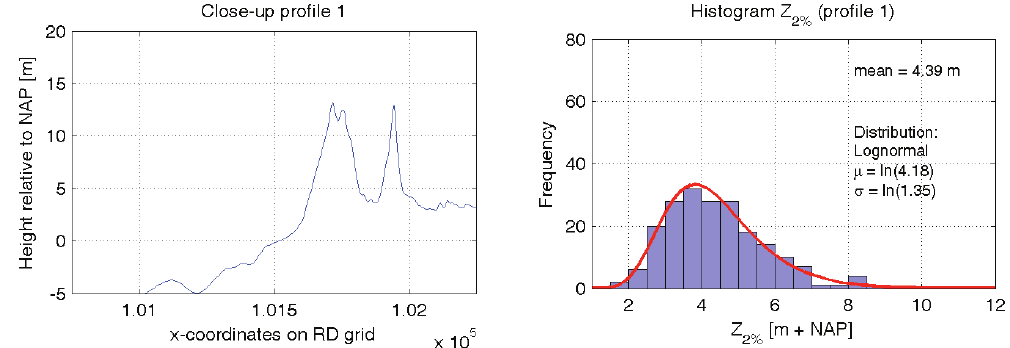
Fig. 4. Left panel: close-up bathymetry profile 1. Right panel: histogram Z2% and best-fit distribution for profile 1.